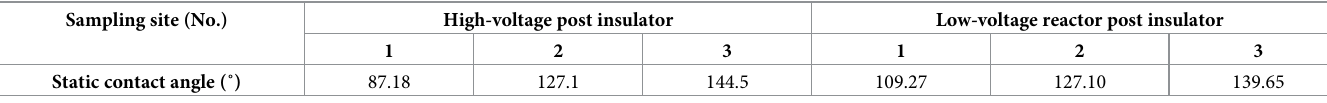
Table 1. Typical static contact angle of RTV.